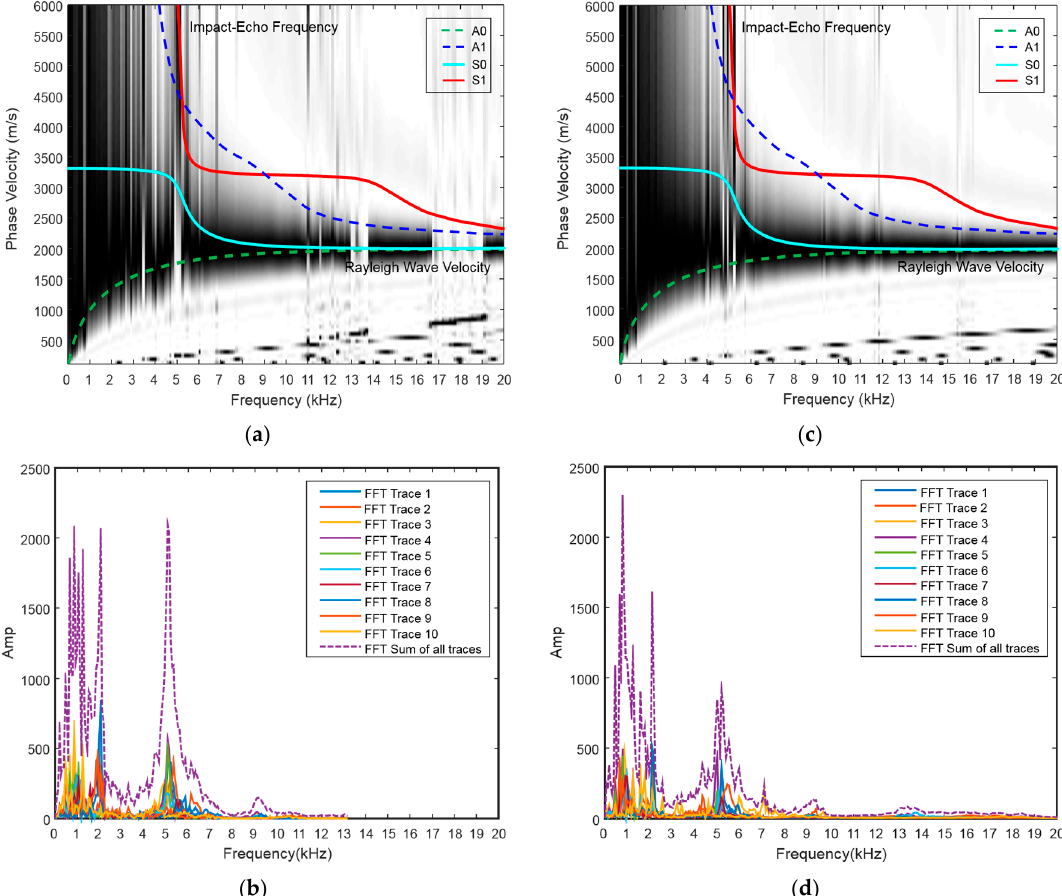
Figure 11. Experimental MASW results for two concrete wide beams (W2 and W4). A Poisson’s ratio of 0.16 was measured for the concrete cylinder. ( a ) Phase velocity dispersion curve along path III in the W2 beam; ( b ) summed amplitude spectra along path III in the W2 beam; ( c ) phase velocity dispersion curve along path II in the W4 beam: ( d ) summed amplitude spectra along path II in the W4 beam.